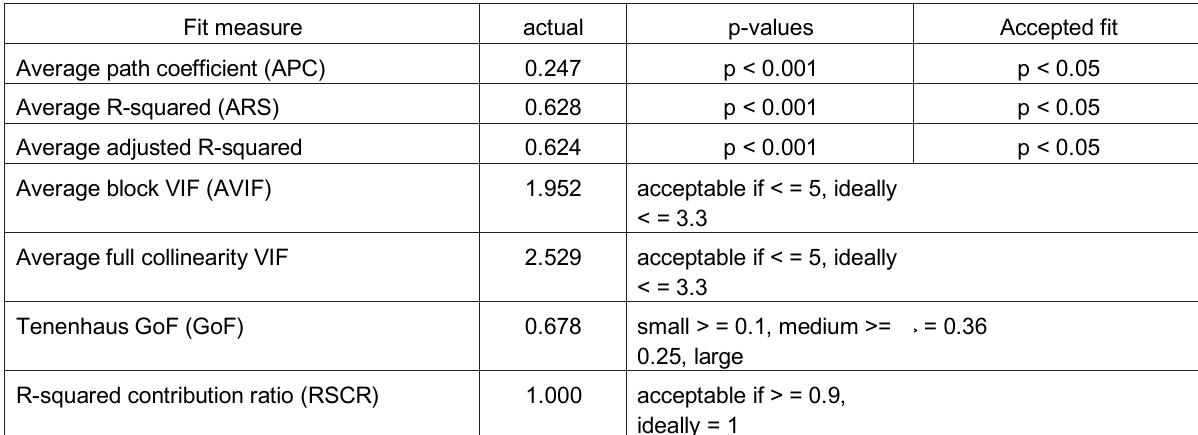
Table 4: Model fit and quality indices